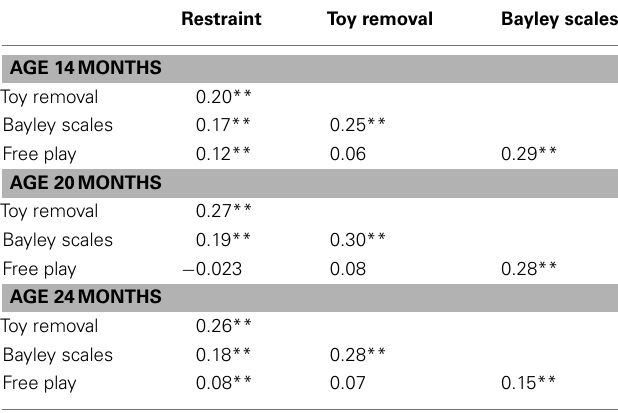
Table 3 | Phenotypic